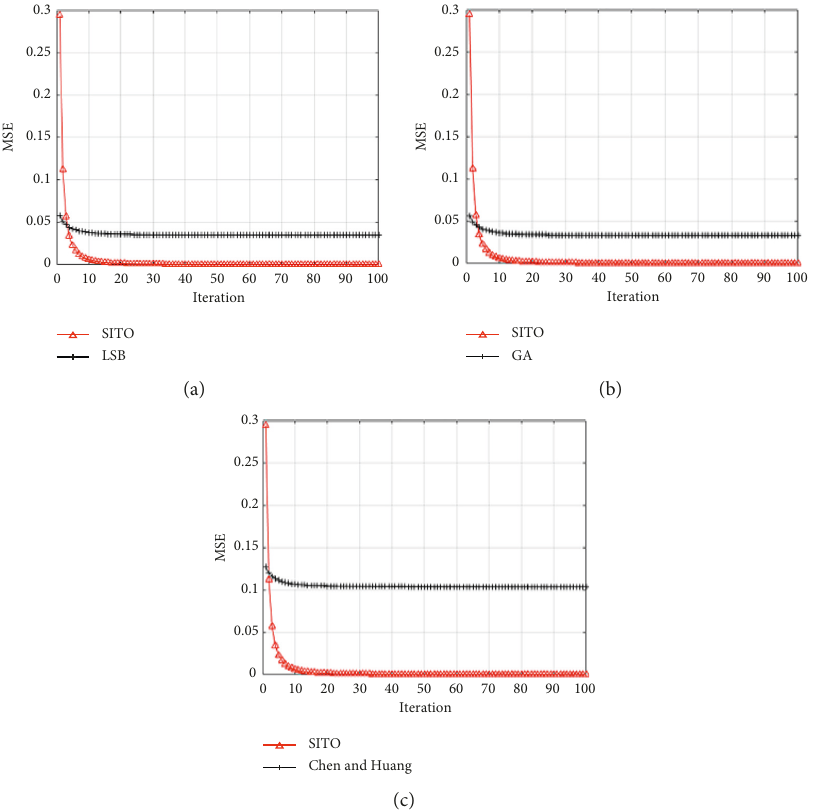
Figure 8: Comparison of MSE variation with (a) LSB, (b) GA, and (c) the method of Chen and Huang [1].